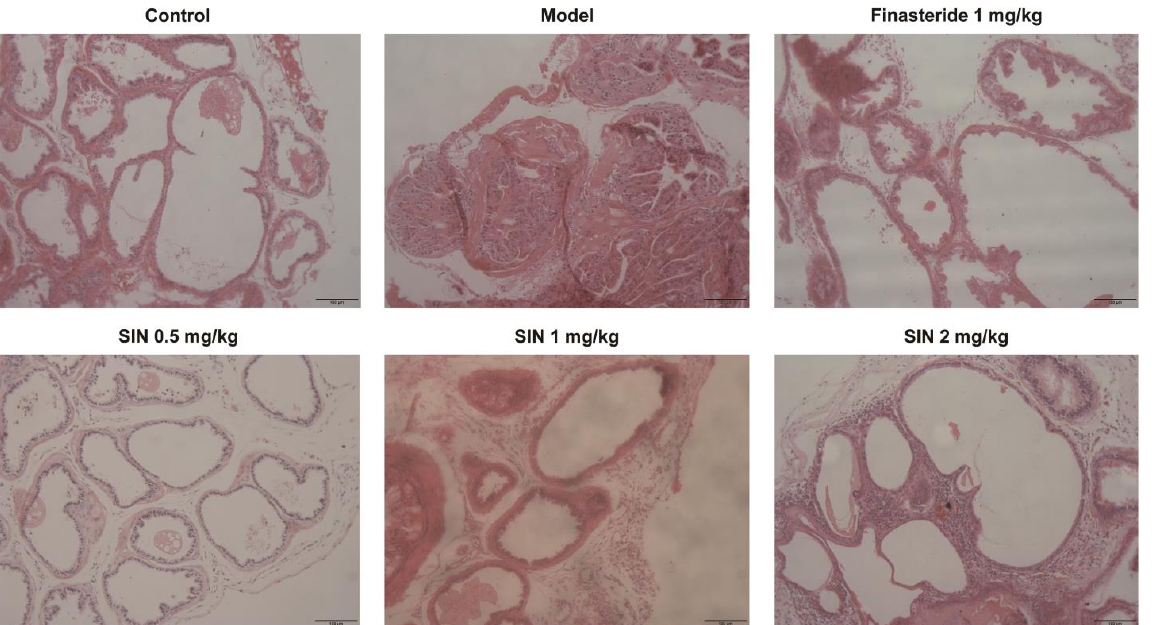
Figure 5. Effect of SIN administration on histological variations of prostate-gland tissue in mice with TP-induced BPH. Representative micrographs of prostate-gland tissue stained with H&E (×200 magnification), scale bar = 100 μm. SIN, sinomenine hydrochloride.